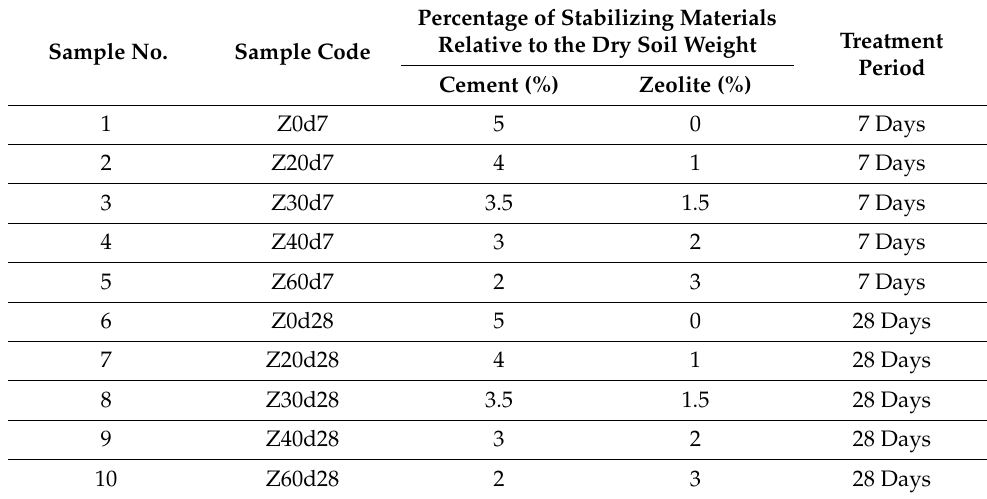
Table 6. Naming, mixing ratios, and treatment time of the tested samples.